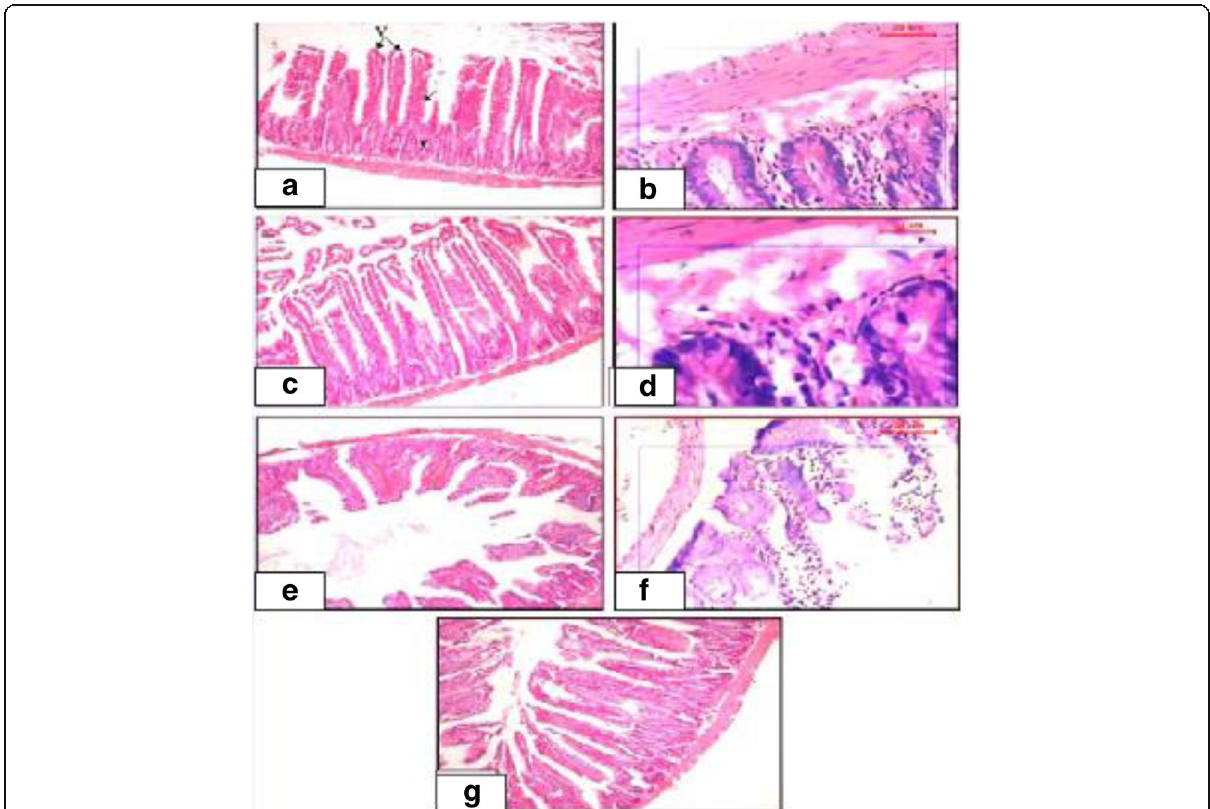
Fig. 3 Photomicrographs of jejunal tissue of the control and treated groups (H&E). a , c Jejunal tissue of control and GABA-treated rats showing normal appearance of the jejunal mucosa with finger-like projections of the villi (V) and normal crypts of Lieberkühn (arrow head) in between the bases of the villi. Enterocytes appeared with normal tall columnar cells and oval basal nuclei; normal goblet cells (arrow) appeared in between the enterocytes (X 100). b , d Jejunal tissue of control and GABA-treated rats showing normal Paneth cells with their pyramidal shaped and broad base setting on the basement membrane. Paneth cells appeared narrow towards the apical end with their prominent eosinophilic granules at the base of Lieberkühn crypts (×200, ×400). e , f Jejunal tissues of IR group showing shortened and thickened villi with marked degenerative changes in the epithelial cells. The lamina propria showed congestion, oedema, increased cellularity, and hemorrhage. Few goblet and Paneth cells were seen. Mucosa showed sub-epithelial space at the apex of some villi with capillary congestion; other villi showed massive lifting of the epithelial layer from the lamina propria. Some denuded villi with exposed lamina propria and dilated capillaries were seen (×100, ×200). g Jejunal tissues of IR + GABA group showing normal villi, but some villi showed apical regions of sub-epithelial lifting with decreased number of goblet cells